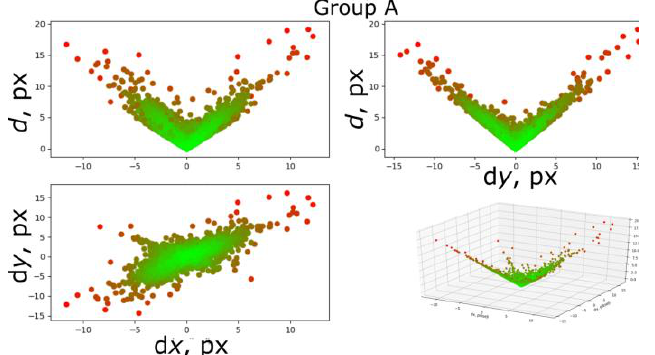
Fig. 9. Video 3, group A